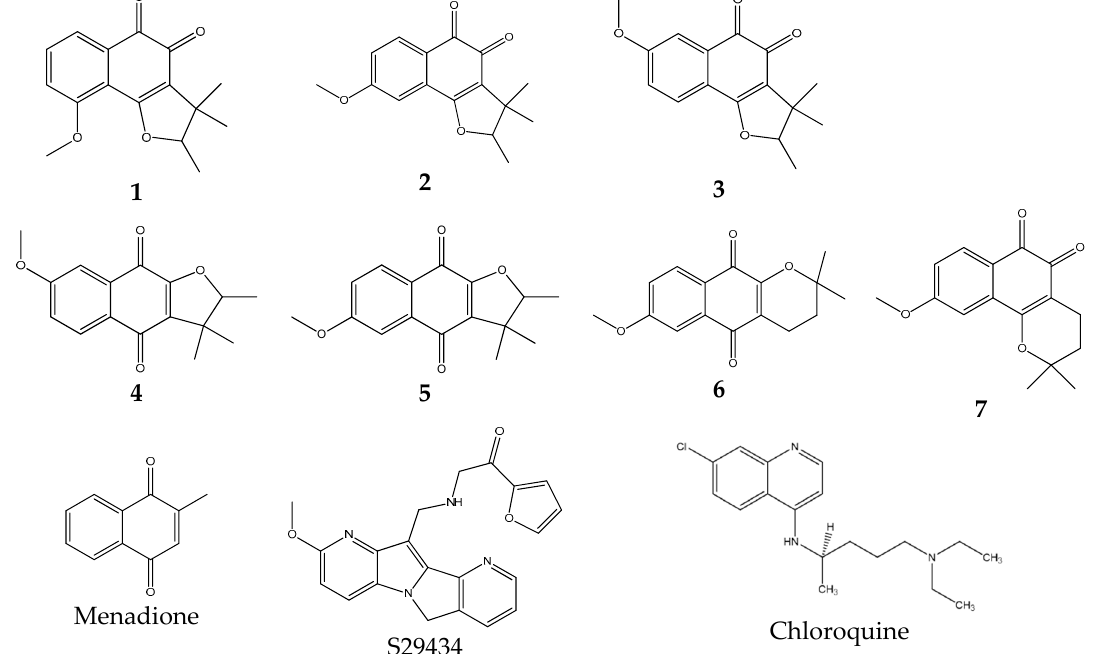
Figure 1. Chemical structures of the compounds tested.